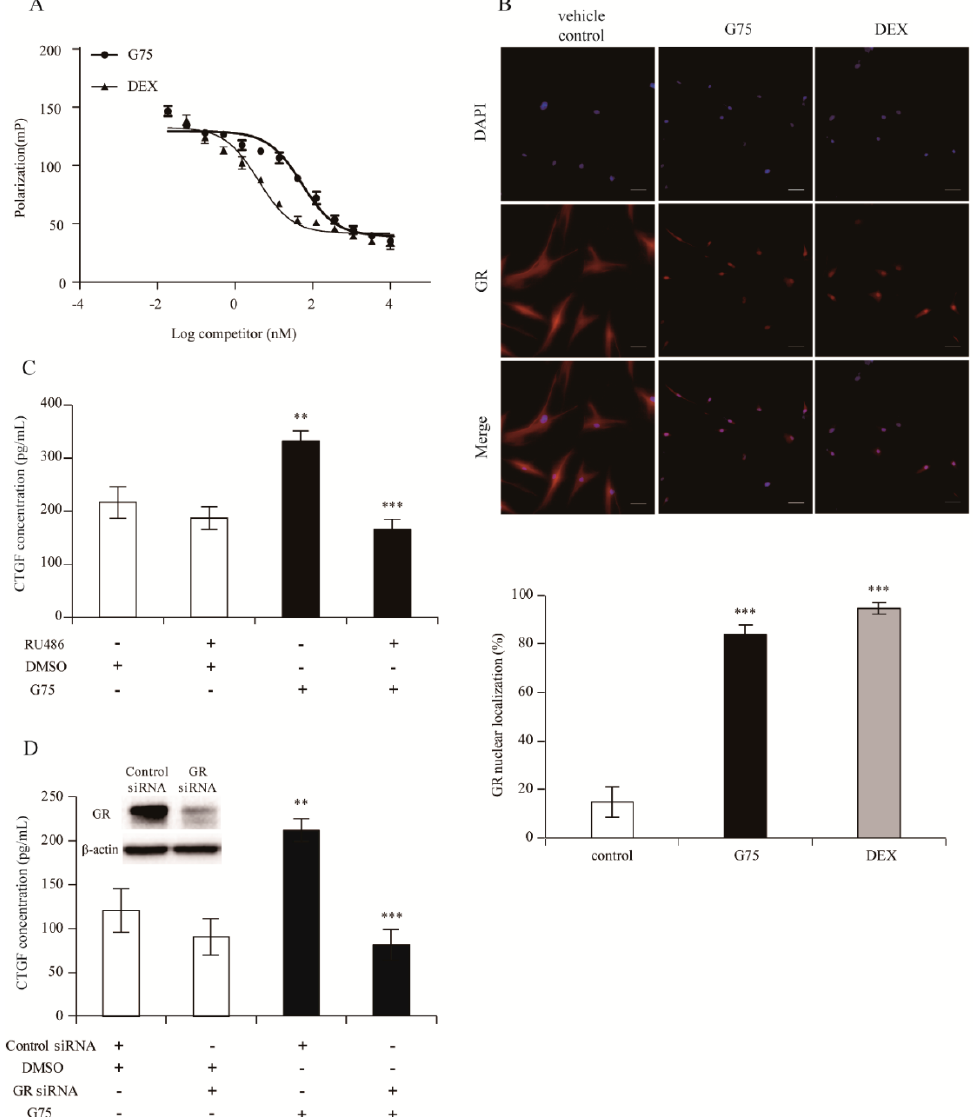
Figure 5. G75-mediated CTGF production through the GR pathway in fibroblasts. ( A ) G75 competitively boundtoGR.DEXwasusedaspositivecontrol. Fluorescentpolarizationisexpressedinmillipolarization (mP). Data represent the mean from three independent experiments. ( B ) G75 induced GR translocation into the nucleus. Fibroblasts were incubated with G75 (5 µ M) or DEX (1 µ M) for 24 h and immunostained with GR antibody (red) and nucleus was stained with DAPI (blue). Original magnification was 400 × . Relative GR translocation is assessed as described in experimental method section. ( C ) Fibroblasts pretreated with RU486 (10 µ M) for 30 min were incubated with G75 (5 µ M) for another 24 h. ( D ) Fibroblasts pre-treated with GR siRNA (10 nM) or control siRNA (10 nM) for 48 h were incubated with DMSO, or G75 (5 µ M) for another 24 h. All experiments were carried out in triplicate. The results are presented as means ± S.E.M ( n = 3). ** p < 0.01, *** p < 0.001, two-tailed Student’s t